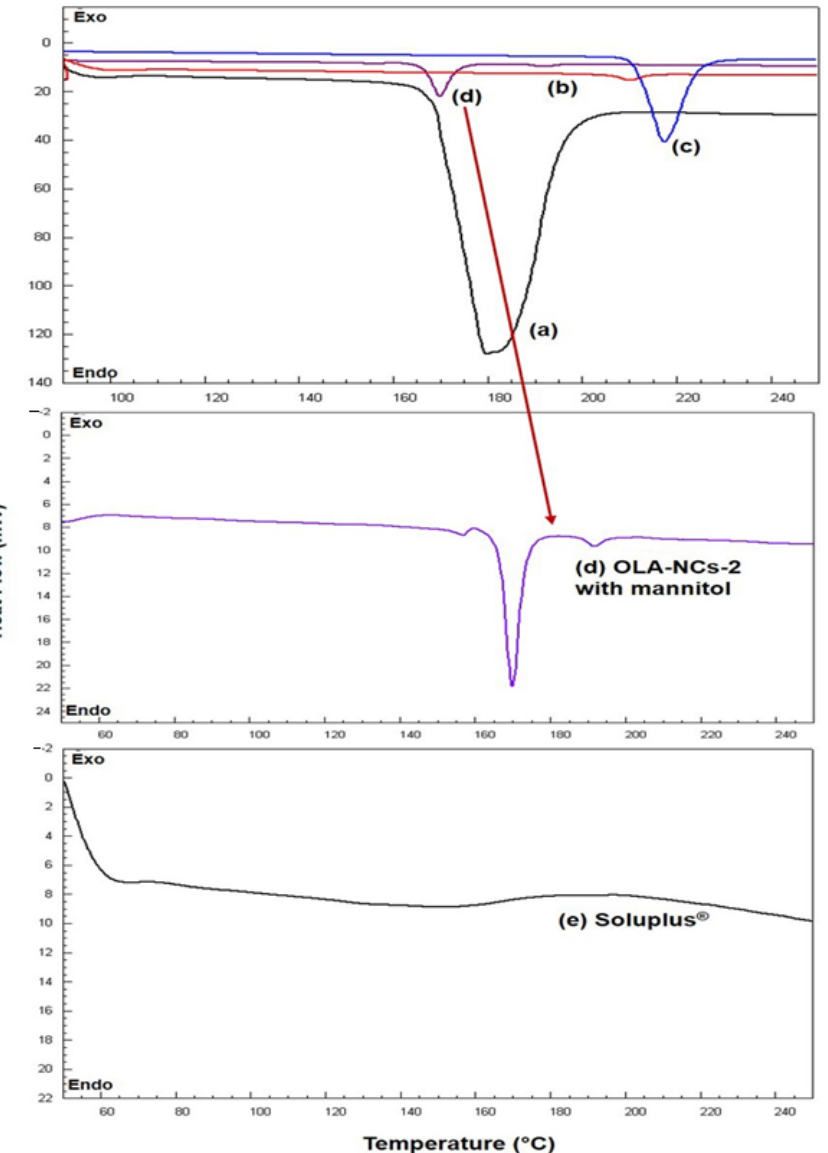
Figure 3. DSC endotherms of mannitol (black color) ( a ); OLA-NCs-2 (red color) ( b ); pure OLA (blue color) ( c ); OLA-NCs-2 with mannitol (dark red color) ( d ) and Soluplus ® (grey color) ( e ).